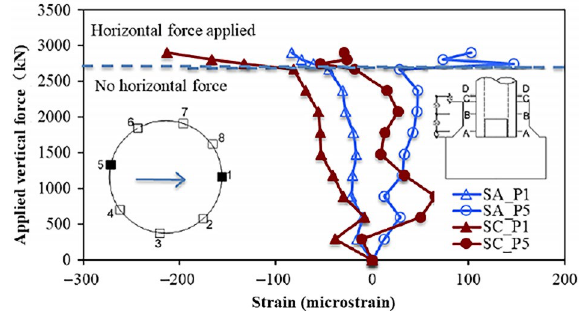
Figure 3. Normal strain versus applied vertical force at Sections A and C of column-foundation connection for Type A in Stage 1